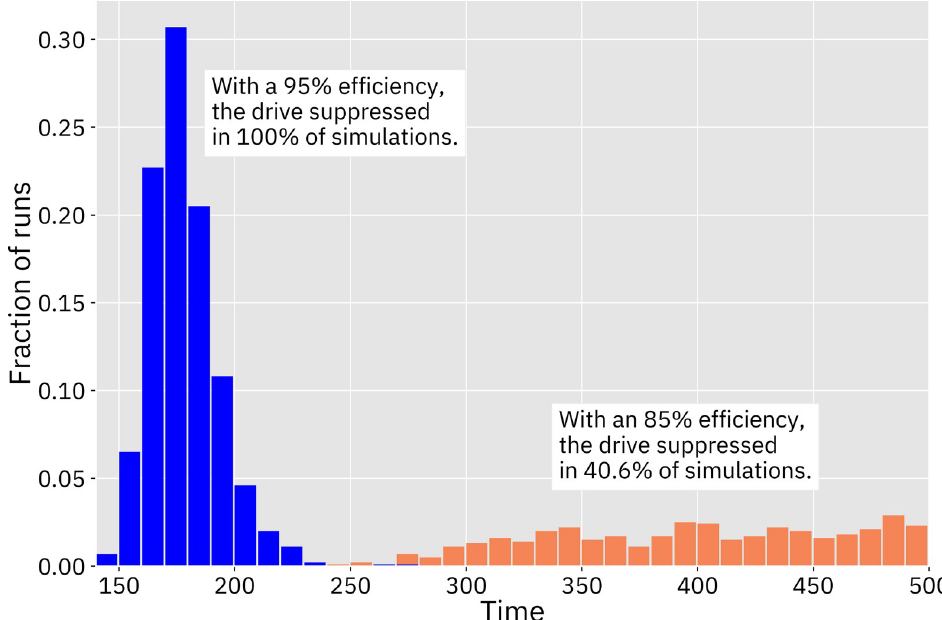
Fig 4. Time from release until suppression for the drive targeting female fertility. Number of time steps until population eradication for the homing drive with a female fertility target using default parameters and a drive efficiency of 95% (blue) and 85% (orange). One thousand simulations were performed for each